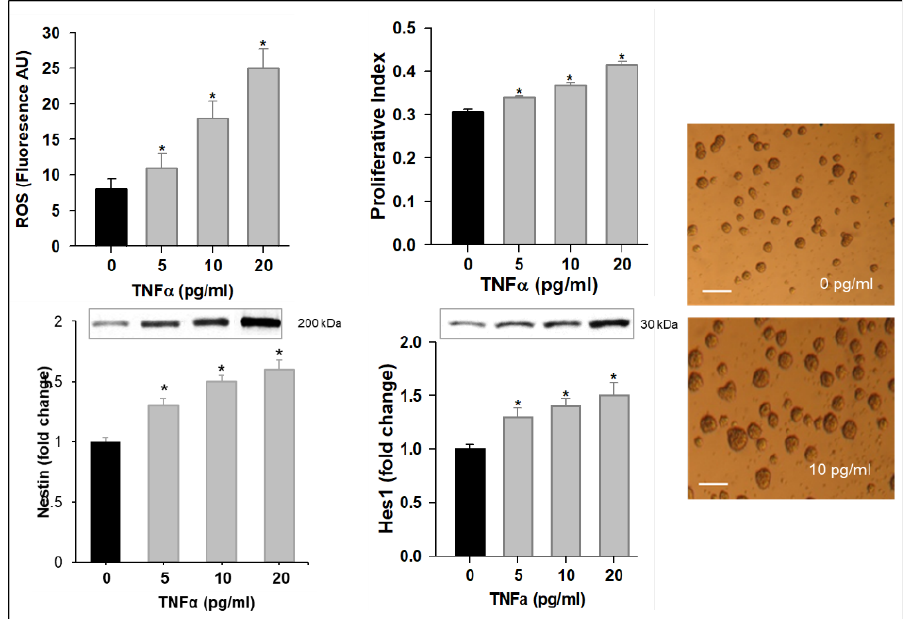
Figure 2 . TNF α Increases NPC ROS and Promotes Proliferation. Hypothalamic NPCs were treated with various doses (5, 10, and 20 pg/mL) of TNFα in complete medium for 24 h. Values are (Mean ± SEM of n = 4 independent experiments with each treatment performed in duplicate) normalized to untreated control cells and expressed as fold change. For protein expression, representative immunoblots are shown. Images of untreated (0 pg/mL) and TNF α -treated (10 pg/mL) cells ( × 20; scale bar = 50 µ m). * p < 0.05 vs. untreated cells.